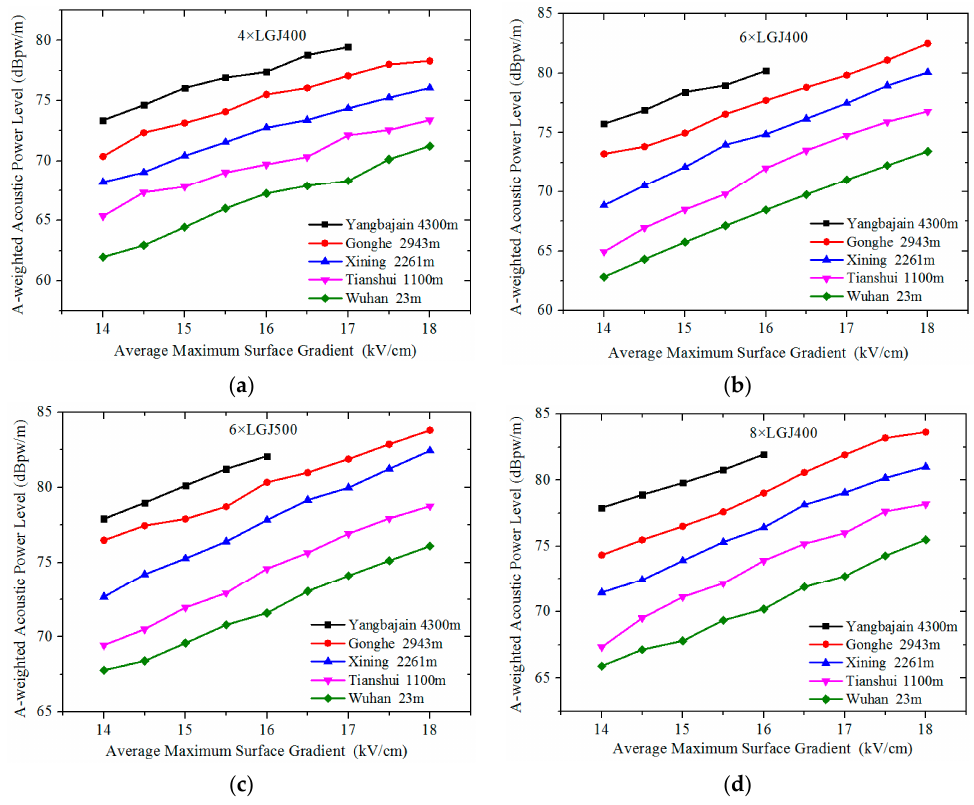
Figure 5. PWL values with different bundle numbers and different subconductor diameters at different altitude areas. ( a ) 4 × LGJ400, ( b ) 6 × LGJ400, ( c ) 6 × LGJ500 and ( d ) 8 × LGJ400.